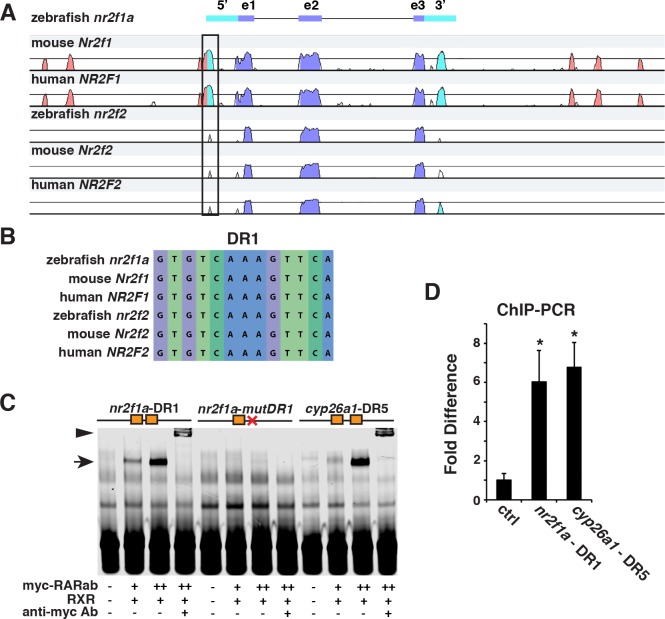
RARs bind a conserved DR1 site within the nr2f1a promoter.(A) mVISTA sequence alignment of 17kb coding and flanking regions for zebrafish, mouse, and human NR2F1 and NR2F2 genes. Box indicates region containing the conserved DR1 site. purple–conserved coding sequence, blue–conserved 5’- and 3’-UTRs, red–conserved sequences outside of the transcribed regions. (B) Conserved DR1 sequence in NR2F genes. (C) EMSA using probes for the nr2f1a - DR1, a mutated nr2f1a - DR1, and control cyp26a1—DR5 sites with increasing amounts of myc-tagged RARabv2 protein. Zebrafish RXRba protein was added to all samples as binding was not observed without RXR. (D) ChIP-qPCR of the nr2f1a DR1 site, negative control site, and a previously reported Cyp26a1 DR5 site (positive control) comparing the association of induced VP16-RARab from hsp70l:EGFP-VP16-RARab embryos to that in non-transgenic control sibling embryos at the 8s stage.